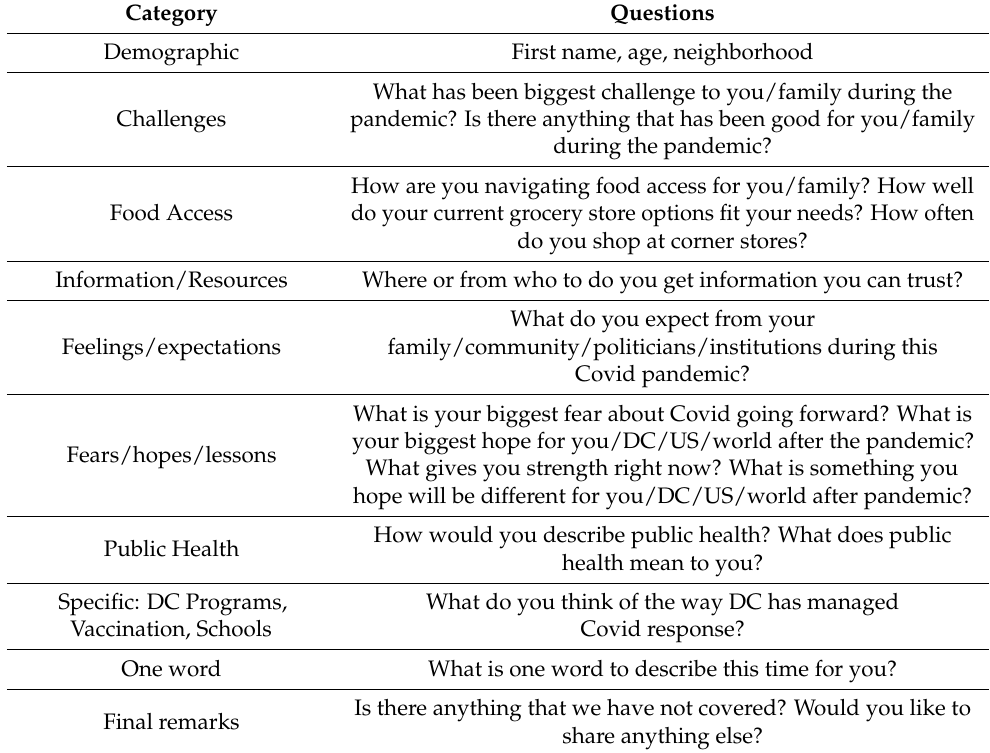
Table 1. Semi-structured interview